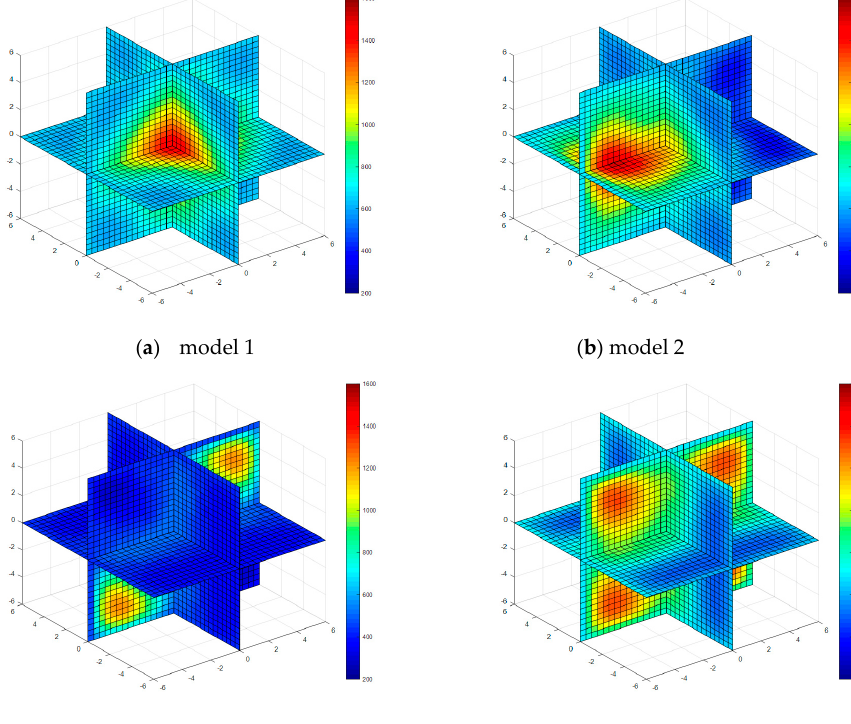
Figure 6. Diagram of reconstructed temperature fields by standard Tikhonov regularization method.